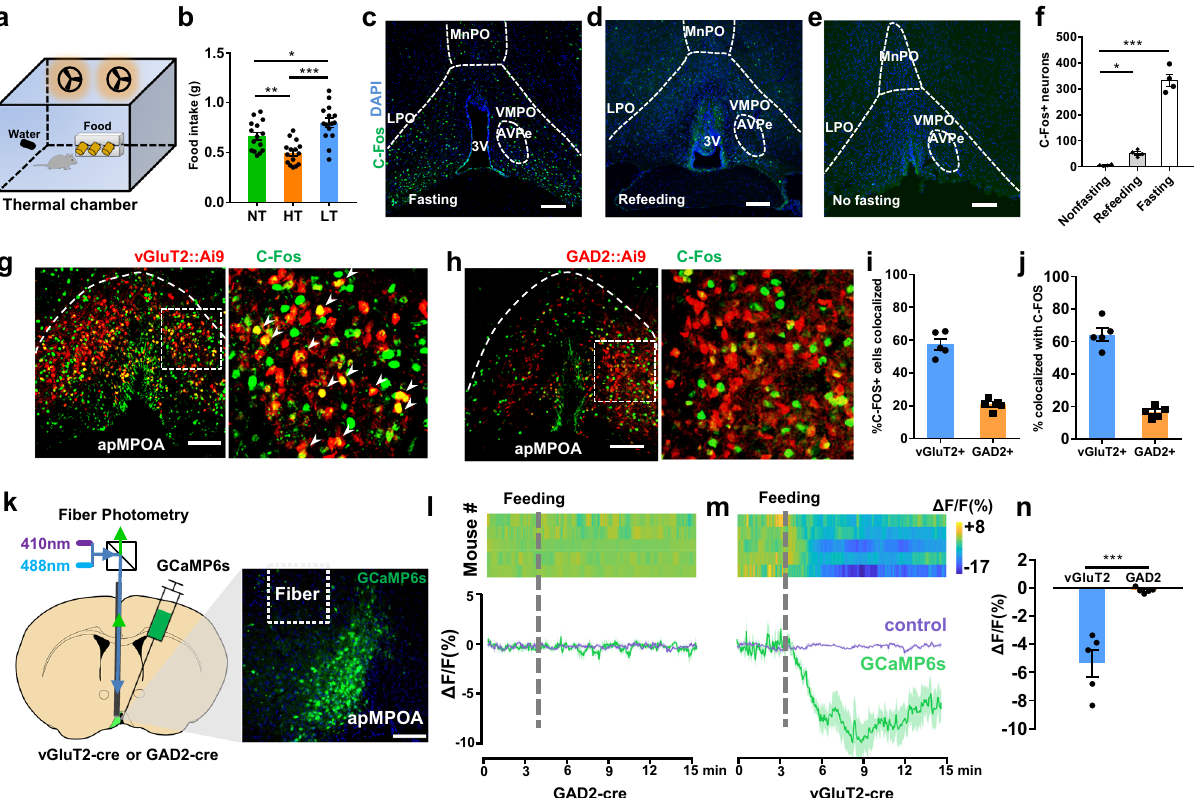
Fig. 1 Glutamatergic apMPOA neurons respond to altered dietary states. a Scheme of feeding test in a temperature-controlled chamber. b Differences of 2 h food intake among the three ambient temperatures. NT neutral temperature, HT high temperature, LT low temperature. One-way ANOVA and post hoc least signi fi cant difference (LSD) multiple comparison, * p = 0.019, ** p = 0.004, *** p < 0.001, n = 15 animals for each group. c – f C-Fos expressions in the apMPOA in three dietary states: 12 h fasting, 2 h refeeding and no fasting. AVPe, anteroventral periventricular nucleus; VMPO, ventromedial preoptic nucleus; MnPO, median preoptic nucleus; 3V, the 3rd ventricle. Scale bar, 100 µ m. One-way ANOVA and post hoc LSD multiple comparison, * p = 0.048, *** p < 0.001, n = 4 animals for each group. g , h Colocalizations of fasting-induced C-Fos (green) with vGluT2 + (red) and GAD2 + neurons (red) in vGluT2::Ai9 ( g ) and GAD2::Ai9 mice ( h ). Images were obtained from transgenic mice by crossing Ai9 (Cre-dependent tdTomato reporter) with vGluT2- cre ( g ), and Ai9 with GAD2-cre ( h ). Scale bar, 100 µ m. i Percentage of C-Fos + neurons that are vGluT2 + and GAD2 + . n = 5 animals for each group. j Percentage of vGluT2 + and GAD2 + neurons that express C-Fos. n = 5 animals for each group. k Scheme of fi ber photometry setup, and representative coronal section of apMPOA neurons expressing GCaMP6s. Image representative of n = 5 mice. Scale bar, 100 µ m. l , m GcaMP6s (mean, green line; SEM, green shading) and control (mean, purple line; SEM, purple shading) signal changes ( Δ F / F ) in response to feeding in GAD2-cre ( l ) and vGluT2-cre mice ( m ) after 24 h fasting. n = 5 animals for each group. n The mean Δ F / F in a 5 min window after the onset of feeding. T test (two-sided), *** p < 0.001, n = 5 animals for each group. All error bars show